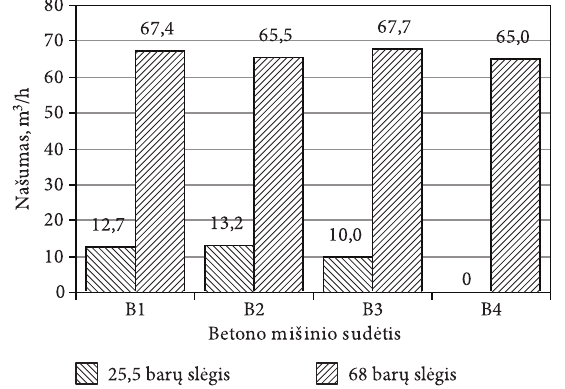
Fig. 3. The dependence between concrete mixtures pump efficiency and concrete mixture‘s